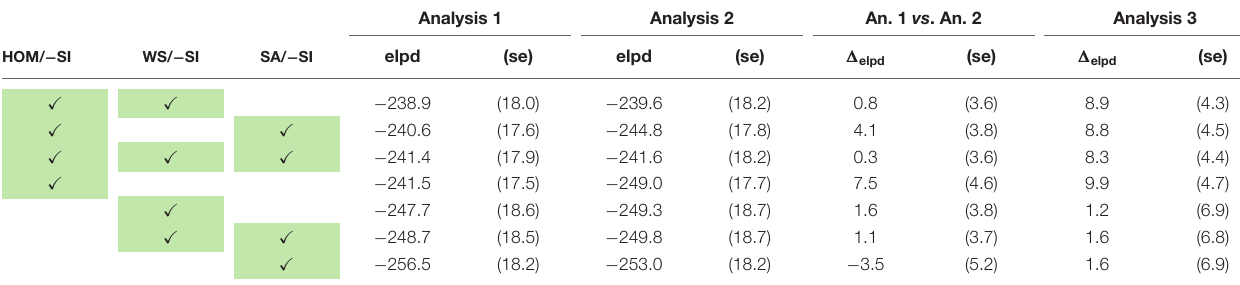
TABLE 9 | Results of leave-one-out cross-validation for Experiment